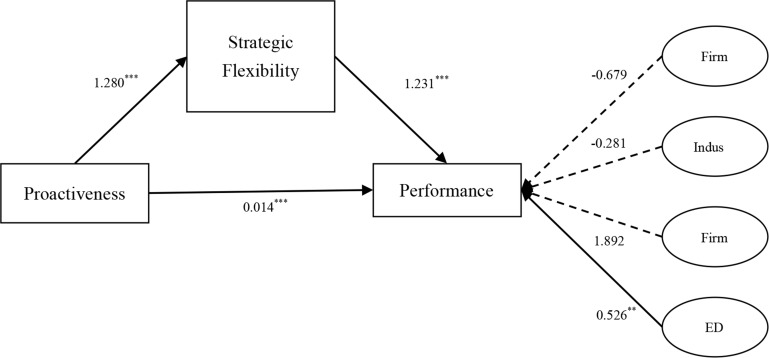
The Mediation Model.